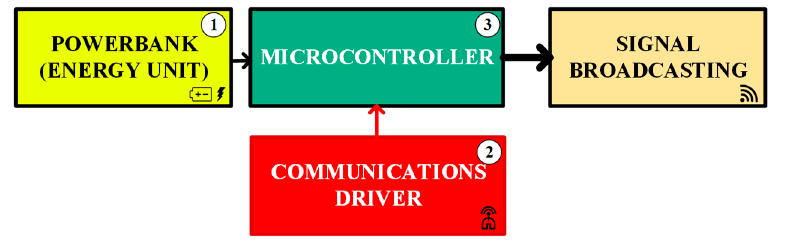
Figure 5. Diagram of the static system.